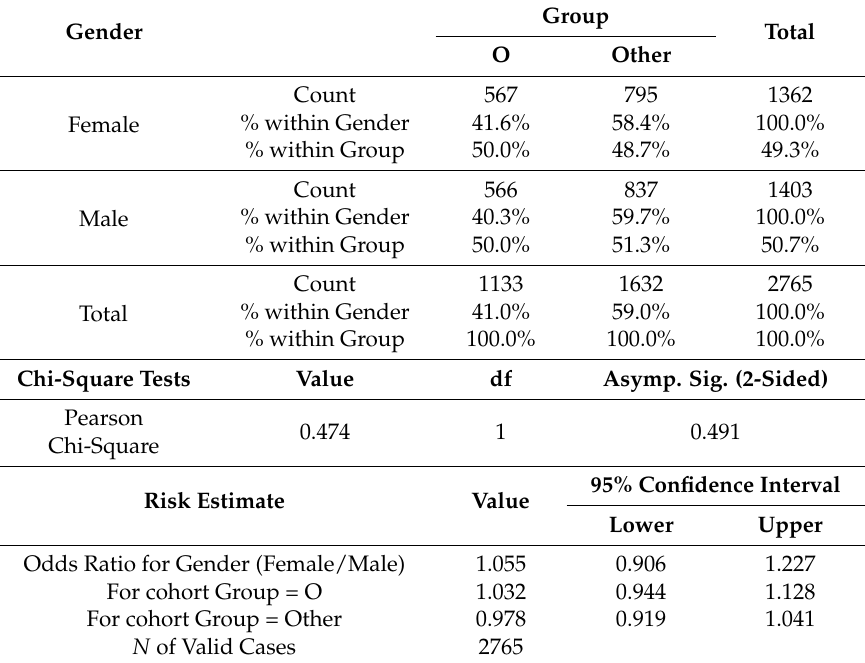
Table 3. Crosstab gender vs. blood group.